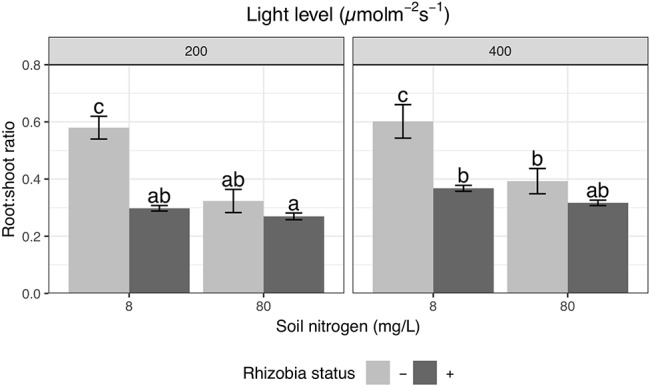
Effects of light, nitrogen, and rhizobia on root:shoot ratio. Error bars represent +/− one standard error (8–11 replicates). Note that root:shoot ratio was ln-transformed to improve normality in the ANOVA but is represented here without transformation for ease of interpretation. Bars with the same letter across the entire figure do not significantly differ after post hoc testing with the Tukey test (P > 0.05).